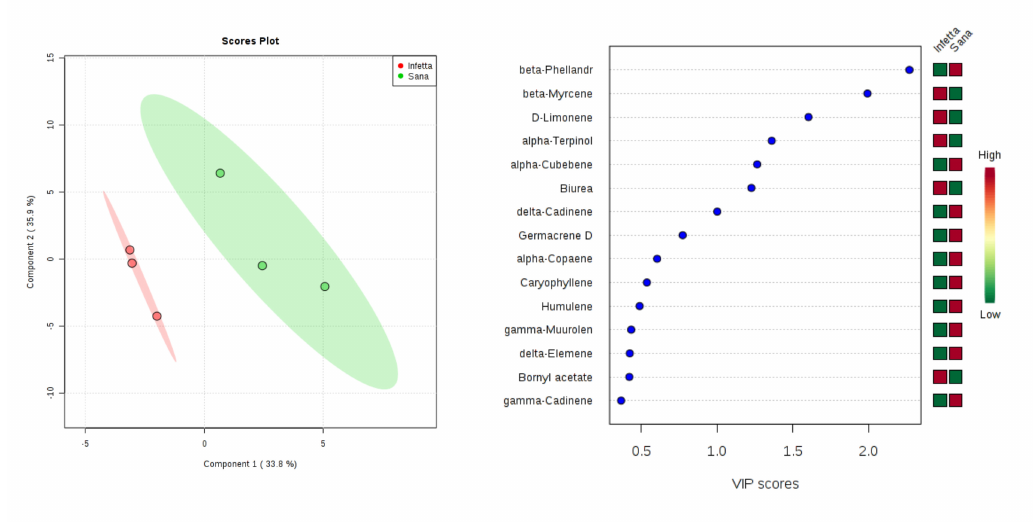
Figure 10. Partial least squares discriminant analysis applied to the Sampling #1 (NEST) in Canolo. Parameters and symbols as in Figure 4.